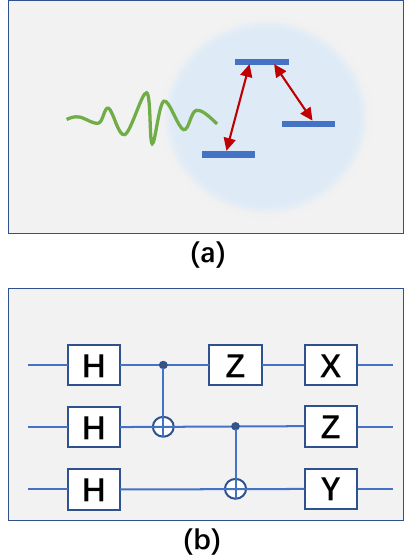
Fig. 2 Schematics of two fundamental quantum control problems. (a) State transition control driven by coherent applied field pulses, which can be generalized to the observable control problem discussed throughout this